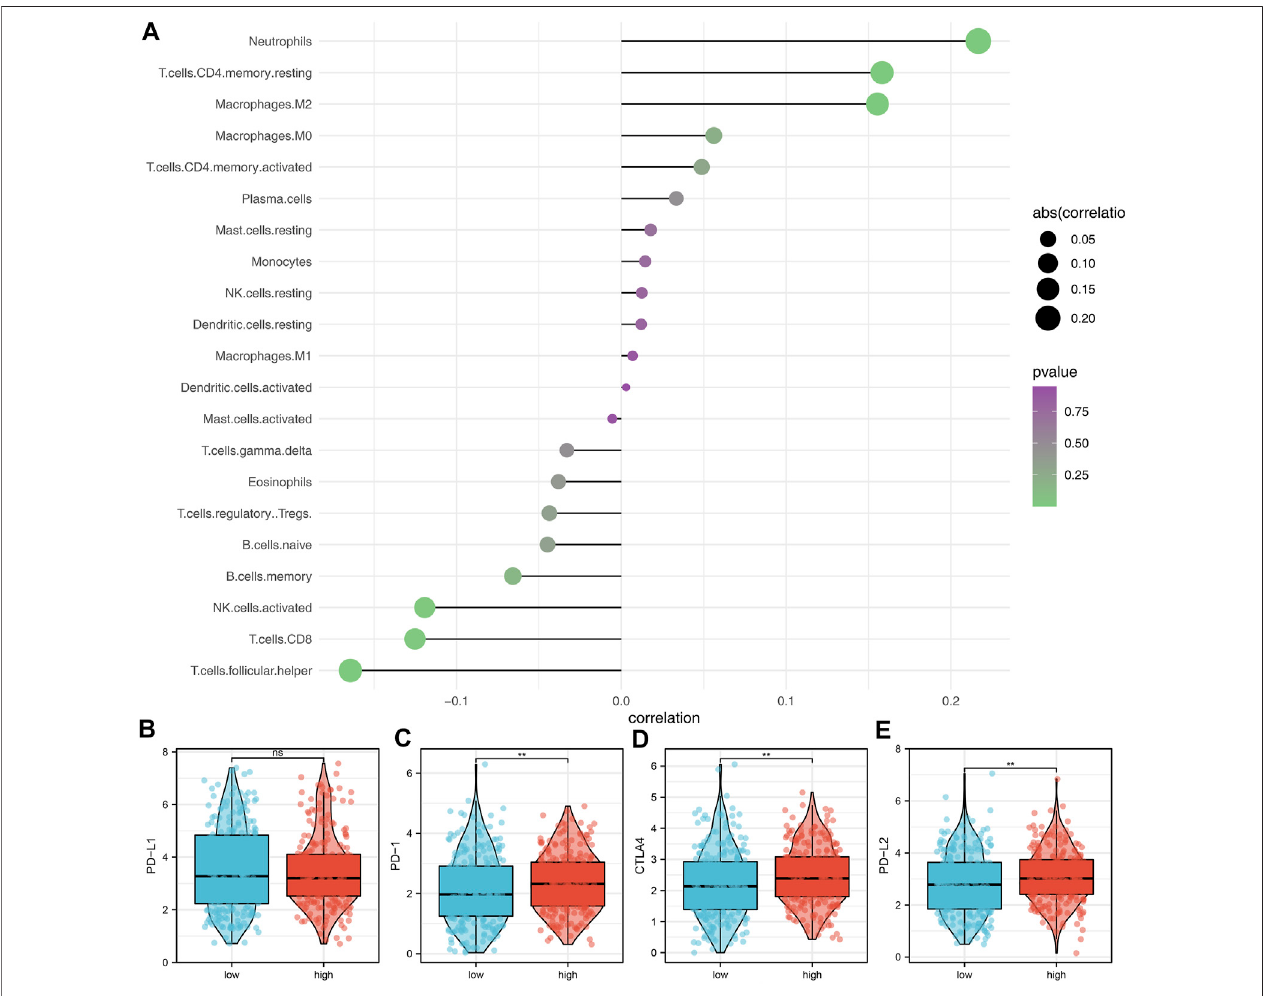
FIGURE6| Immunein fi ltrationanalysis. (A) Immunein fi ltrationanalysiswasperformedusingtheCIBERSORTalgorithm; (B – E) ExpressionoflevelofPD-L1,PD-1, CTLA4, and PD-L2 in the high- and low-risk groups.